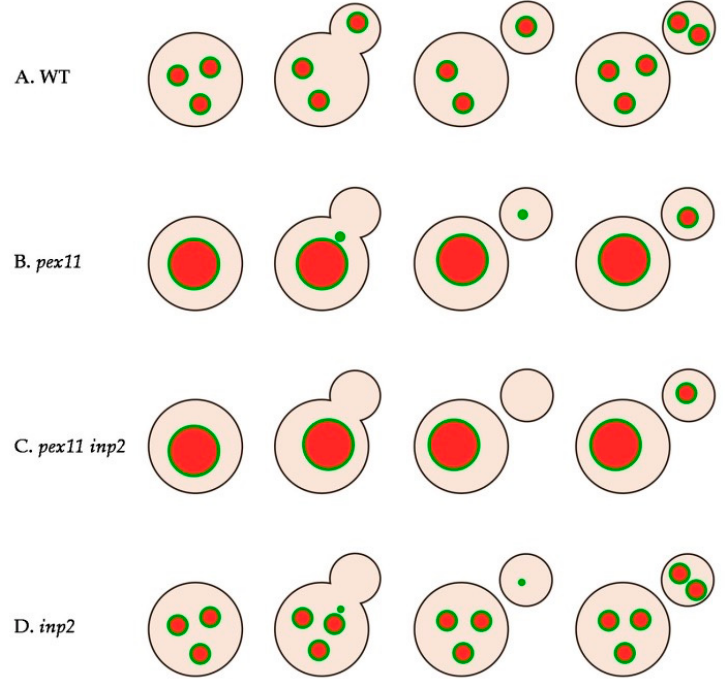
Figure 8. Model representing peroxisome fission and inheritance during cell budding in different strains of H. polymorpha grown on methanol. ( A ) In WT cells fission and inheritance are fully functional resulting in at least one of the multiple peroxisomes being transferred from the mother cell to the forming bud. ( B ) The enlarged single peroxisome in the pex11 mutant is retained in the mother cell while a fragment of its membrane pinches off, followed by transfer to the daughter cell. This event is observed in ~50% of budding cells. The remaining ones display a situation typical for the pex11 inp2 double mutant population ( C ), where nascent cells do not inherit any peroxisomal structure and have to form peroxisomes from a scratch. ( D ) inp2 mutant contains multiple peroxisomes since fission is not defective in this strain. During cell budding a small organelle is transferred from the mother cell to the nascent bud, where it grows and can undergo fission.